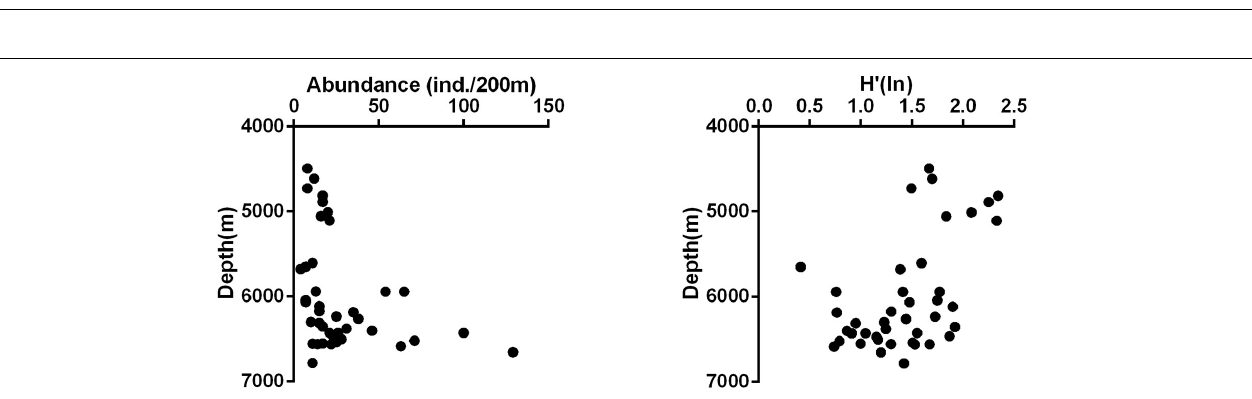
FIGURE 2 | In situ photos of megafauna in the Yap Trench. (A) Rhizophyta yapensis and Relicanthus sp., 4,781 m (D109); (B) Cladorhiza sp., 5,042 m (D149); (C) Abyssopathes sp., 4,862 m (D109); (D) Ctenophora sp., 6,777 m (D111); (E) Polynoidae sp.2, 6,258 m (D112); (F) Polychaeta sp.2 and Chondrocladia (Symmetrocladia) lyra , 5,062 m (D149); (G) Mysidae spp. 6,554 m (D113); (H) Benthesicymus cf. crenatus , 5,109 m (D149); (I) Munnopsidae spp., 6,269 m (D112); (J) Synallactida sp.2, 5,091 m (D149); (K) Elpidiidae sp.1, 6,414 m (D152); (L) Peniagone sp.1, 4,994 m (D149); (M) Freyella sp., 5,715 m (D110); (N) Styracaster yapensis , 6,576 m (D113); (O) Ophiopyrgidae sp.1, 5,123 m (D149); (P) Typhlonus nasus , 4,900 m (D109); (Q) Ophidiidae sp.1, 5,071 m (D149); (R) Pseudoliparis swirei , 6,509 m (D152); (S) Ascidiacea sp.1, 6,351 m (D112).